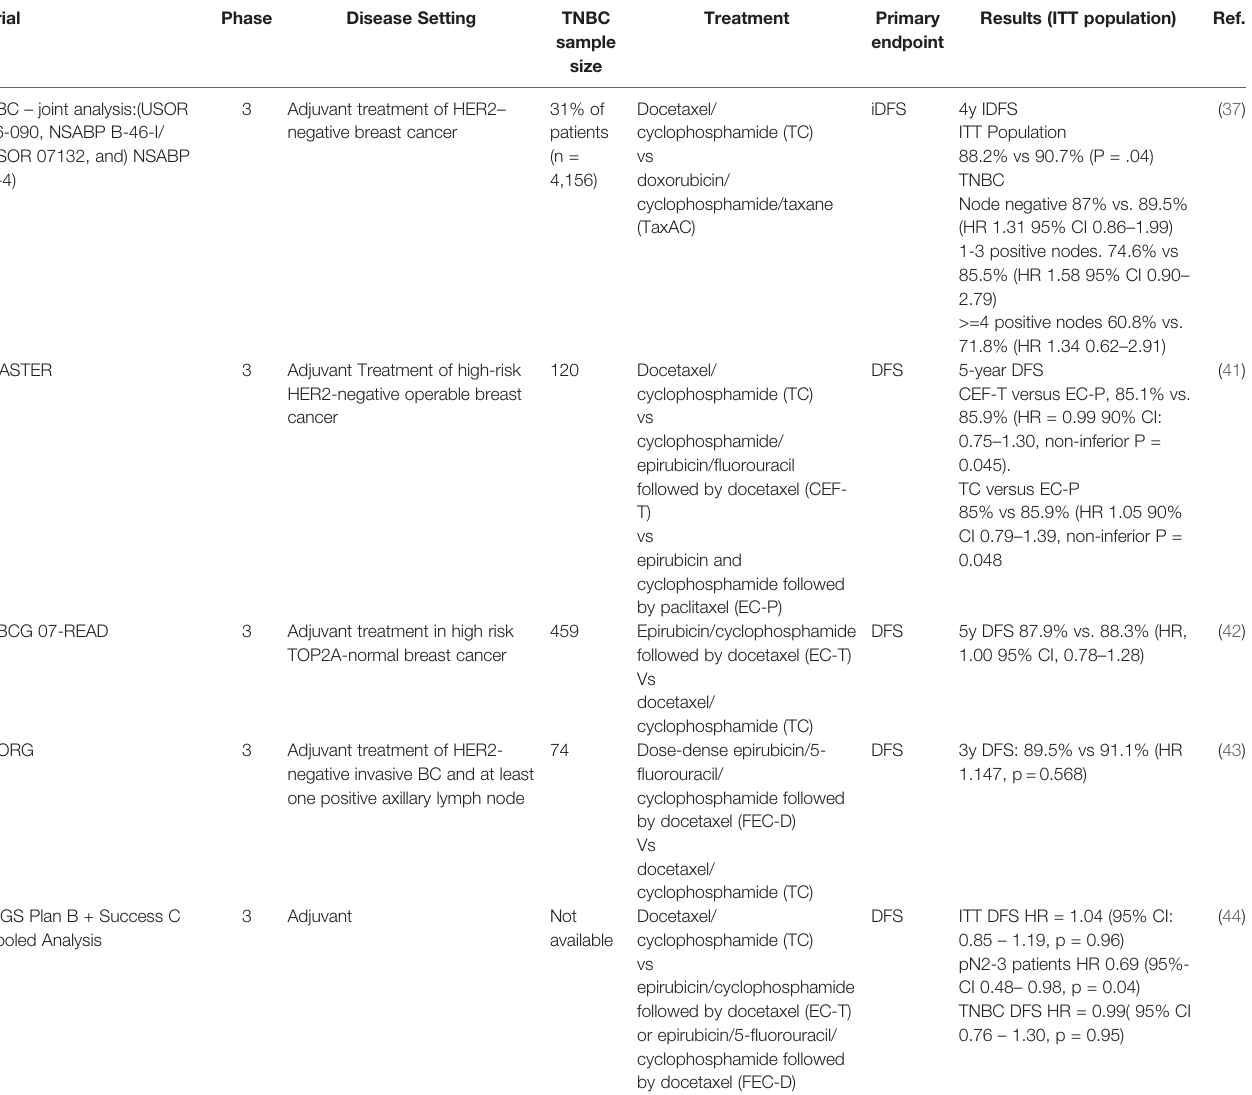
TABLE 3 | Major clinical trials evaluating adjuvant anthracycline-free chemotherapy regimens for patients. with stage I-III TNBC. Trial